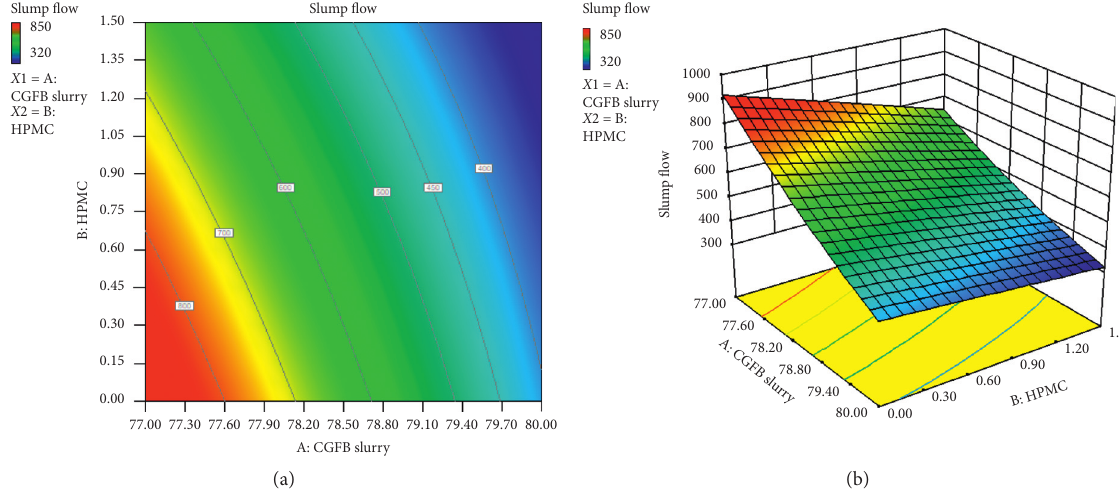
Figure 7: Response surface plot of slump flow. (a) Two-dimensional diagram. (b) Three-dimensional diagram.